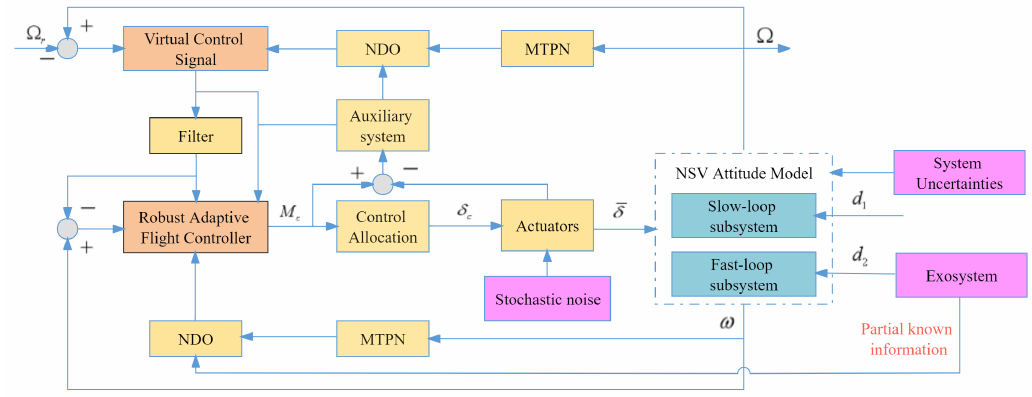
Figure 2. Robust adaptive control structure